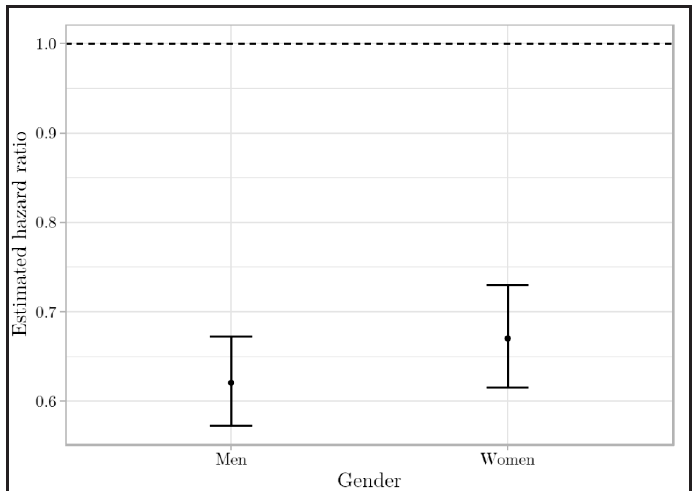
Figure A6 Heterogeneous effects: